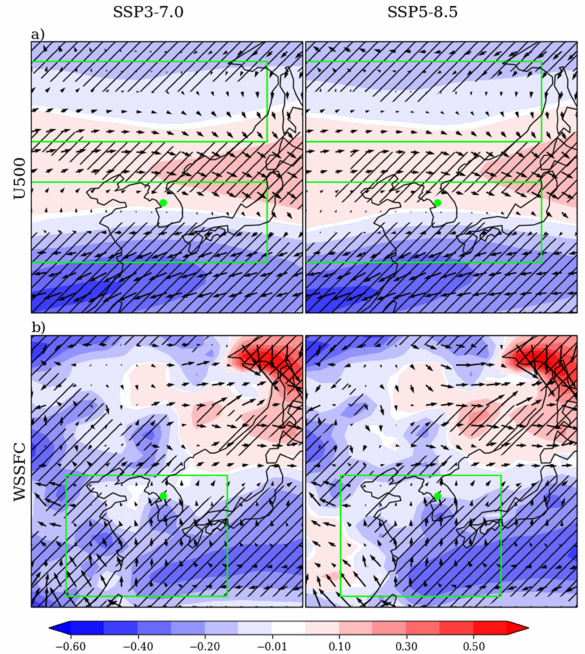
Figure 8. Di ff erences in the composite pattern anomalies of winter between the long-term future (2081–2100) and historical period (1995–2014) of MKPI > 0 conditions near Seoul (37.5N, 127E). ( a , b ) Di ff erences in flow at 500 hPa and surface (long-term future minus historical) for SSP3-7.0 (left) and SSP5-8.5 (right). The green dots denote the location of Seoul; green boxes denote the regions for the calculation of U500 and WSSFC. The stippling areas indicate significant regions at the 95% confidence level based on the Student’s t